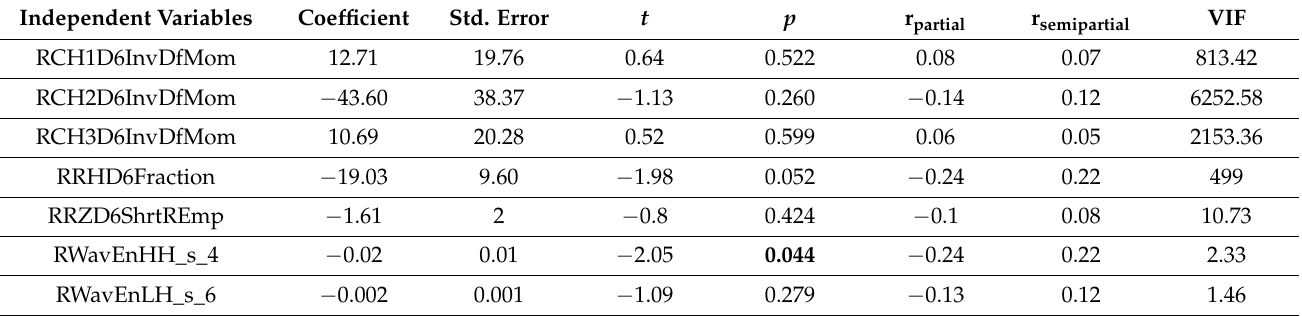
Table 4. Multivariate analysis of the parameters independently associated with the HER2+ status.